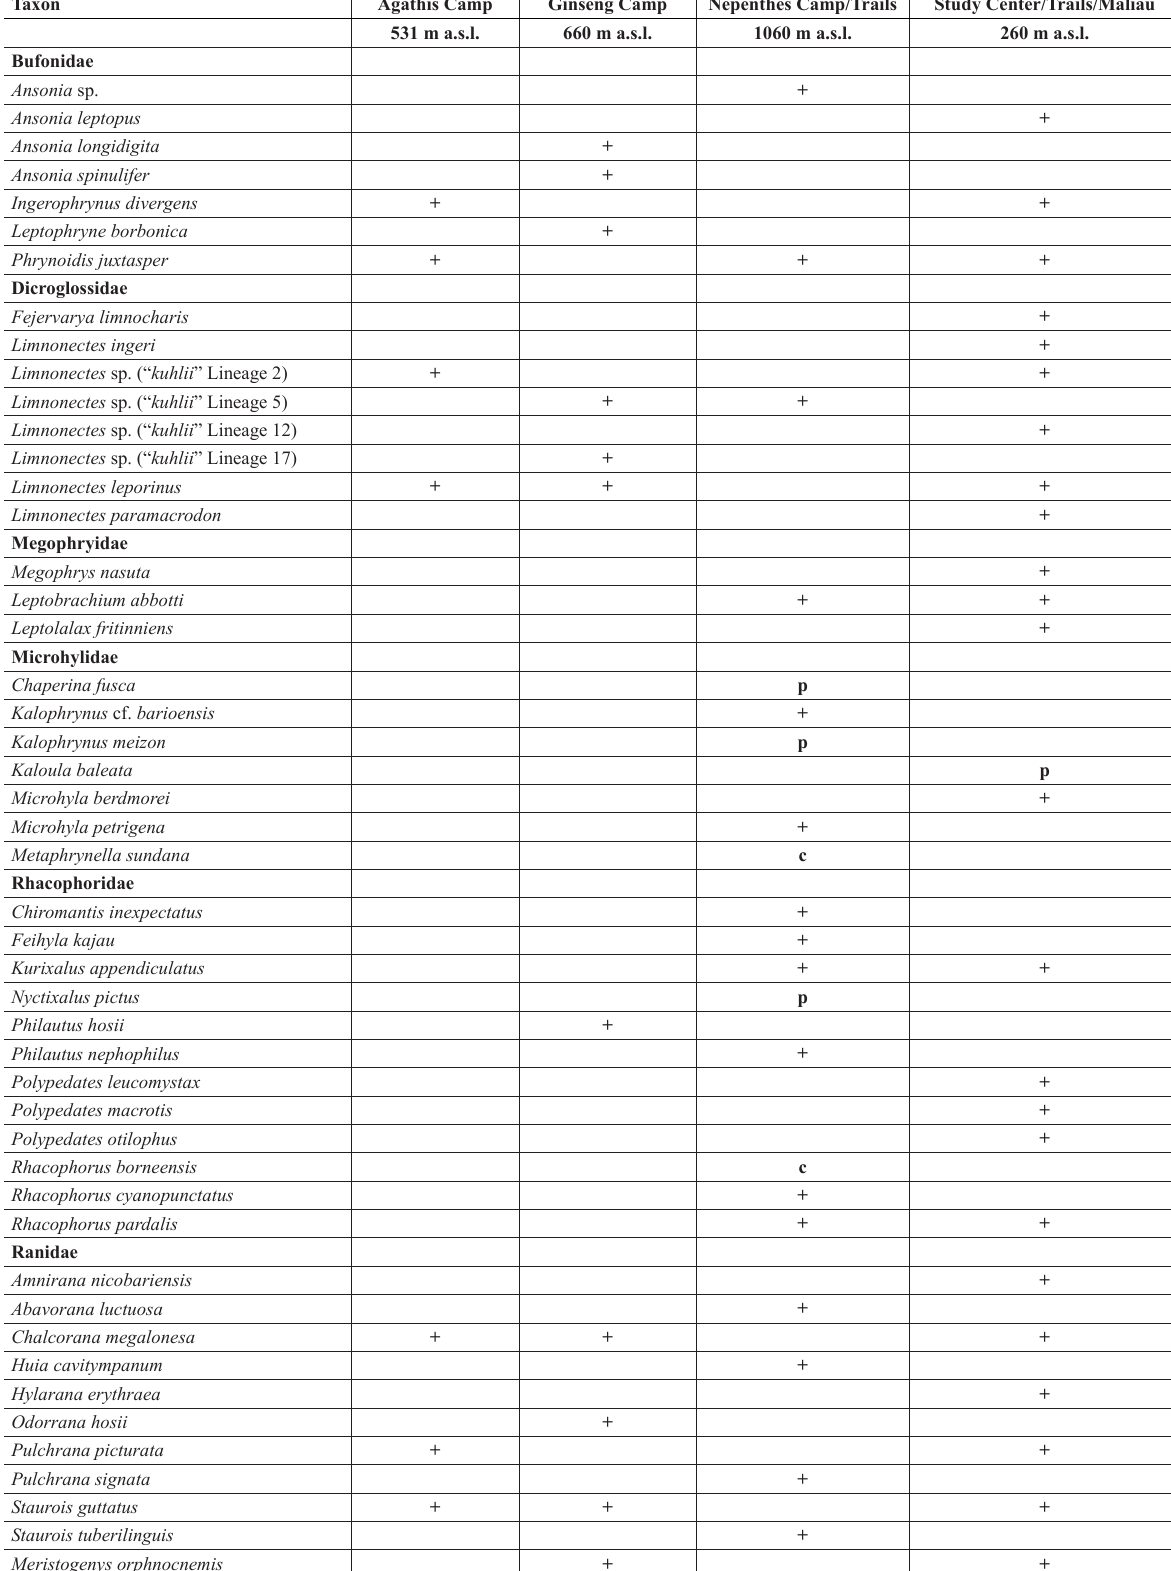
Table 1. List of anuran species encountered at MBCA with the species composition present at four different sites. + = specimens recorded during a two-week survey at Maliau Basin Conservation Area (MBCA), voucher specimens were collected; c = present during two-week survey, identified by call, not collected; p = additional species photographically recorded outside the two-week study period, not collected. With reference to Matsui et al. (2016), we list four genetically divergent lineages of Creek Frogs (“ kuhlii